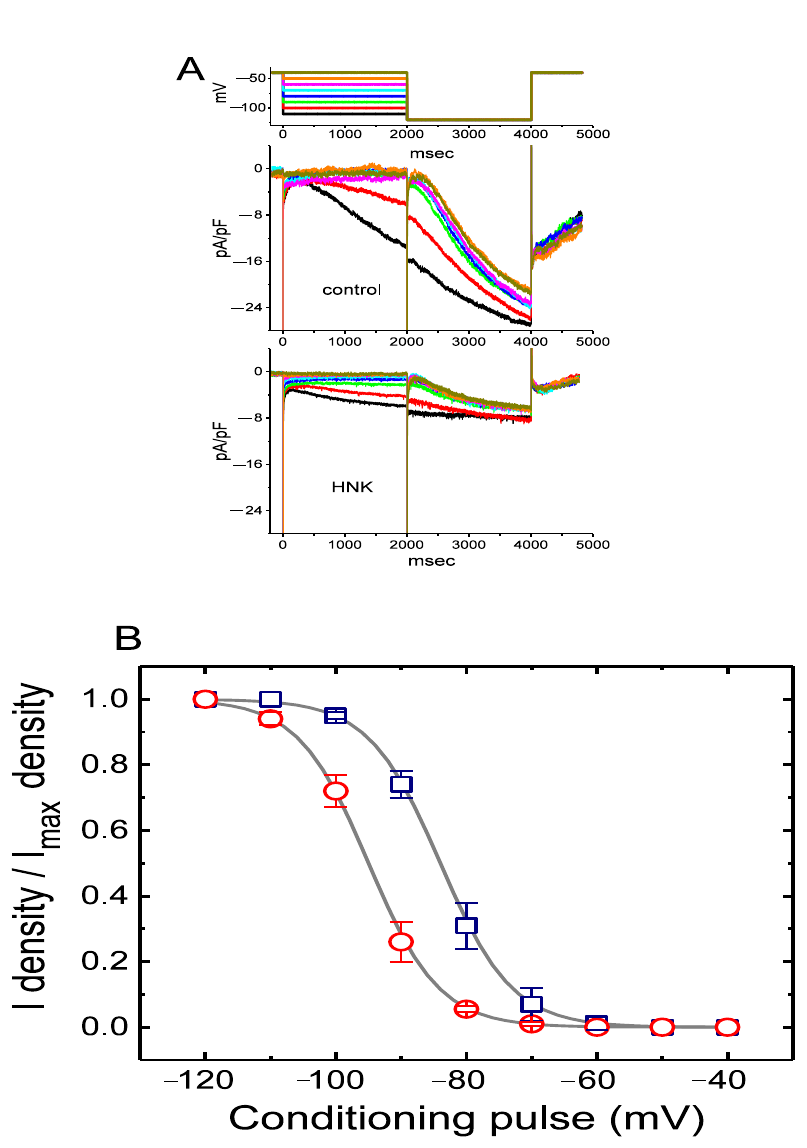
Figure 2. Effect of HNK on the steady-state activation curve of I h density measured from GH 3 cells. These experiments were conducted with a two-step voltage pulse. The conditioning voltage pulses with a duration of 2 s to the potentials ranging from − 120 to − 40 mV. After each conditioning pulse, a test pulse to − 120 mV with a duration of 2 s was delivered to evoke I h density. ( A ) Representative I h densities elicited in response to the two-step protocol as indicated in the uppermost part. Current densities in the upper or lower panel were obtained in the absence (upper) or presence (lower) of 10 µ M HNK, respectively. The uppermost part is the voltage protocol used. ( B ) Steady-state activation curves of I h density in the control ( (cid:3) ) and during cell exposure to 10 µ M HNK ( ) (mean ± SEM; n = 7 for each (cid:35) data point). Current densities were taken at the end of hyperpolarizing pulse. The sigmoidal smooth curves indicate the least-squares fits to the Boltzmann equation elaborated in Materials and Methods